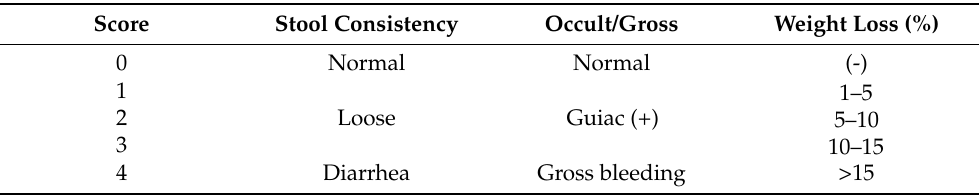
Table 1. Disease activity